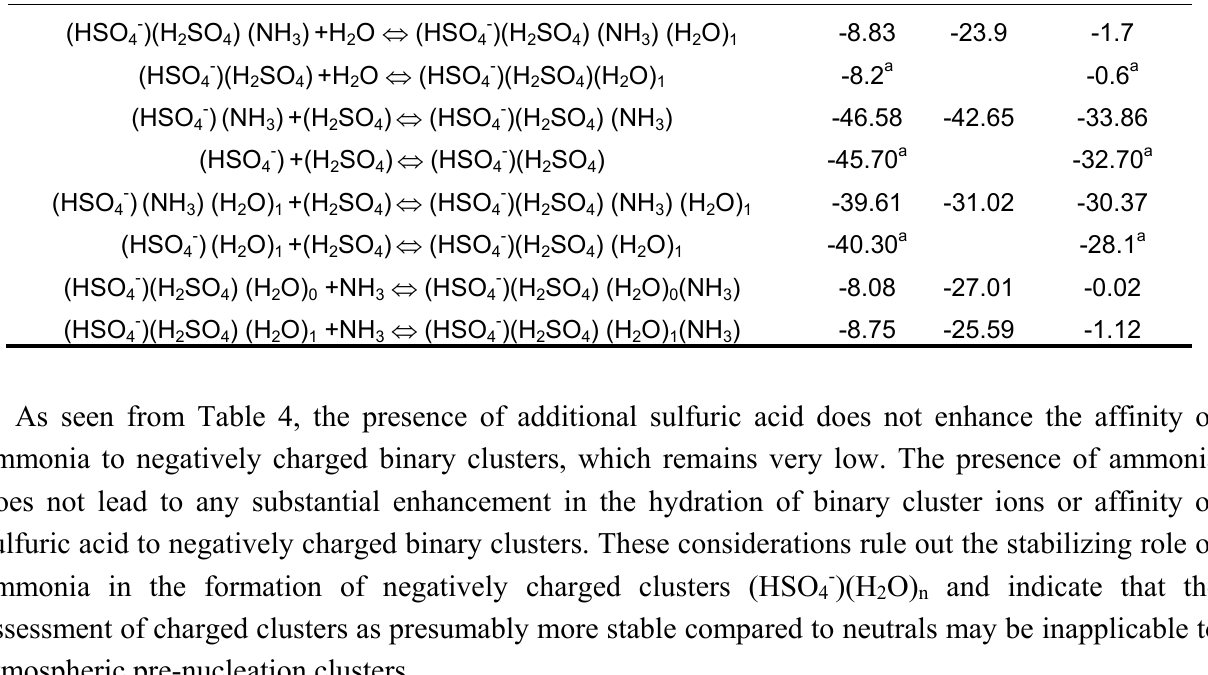
SO ) (NH )(H O) and (HSO 4- )(H 2 4 3 2 n